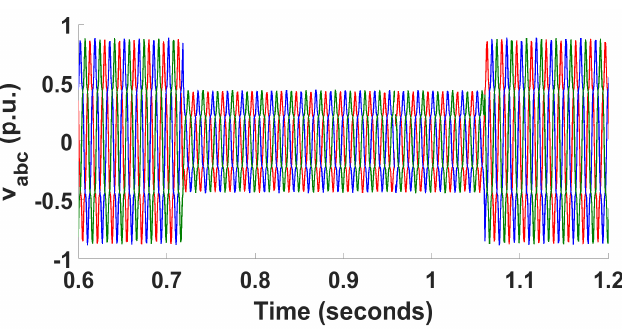
Figure 10. Balanced grid voltage sag under the presence of the 5th harmonic.